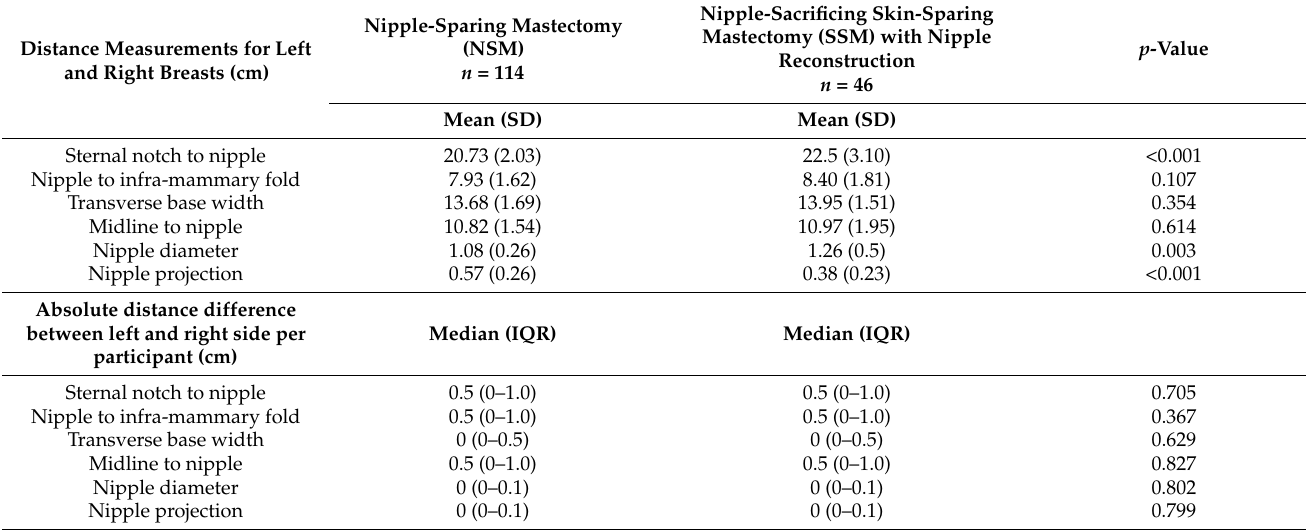
Table 2. Anthropometric measurements to assess nipple symmetry for the left and right breast comparing the NSM and non-NSM groups. The absolute distance difference between the left and right measurements were compared between the NSM and SSM groups.